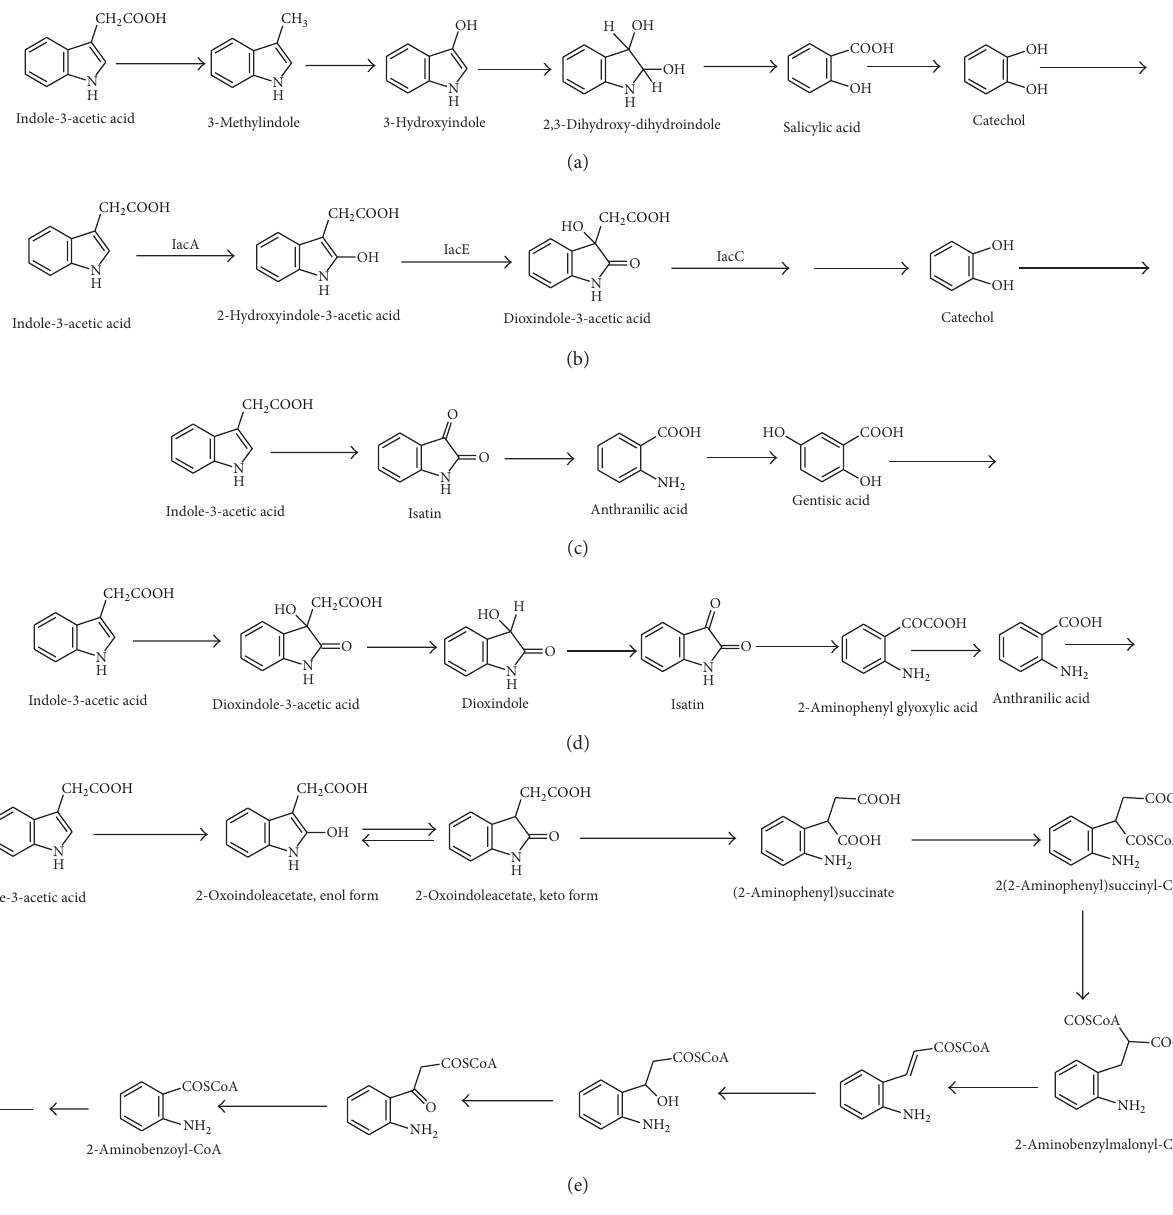
Figure 6: Degradation pathways of indole-3-acetic acid in (a) a Pseudomonas sp. [40]; (b) Pseudomonas putida 1290 [41]; (c) Alcaligenes sp. In 3 [37]; (d) Bradyrhizobium japonicum [42]; (e) Azoarcus evansii [43].